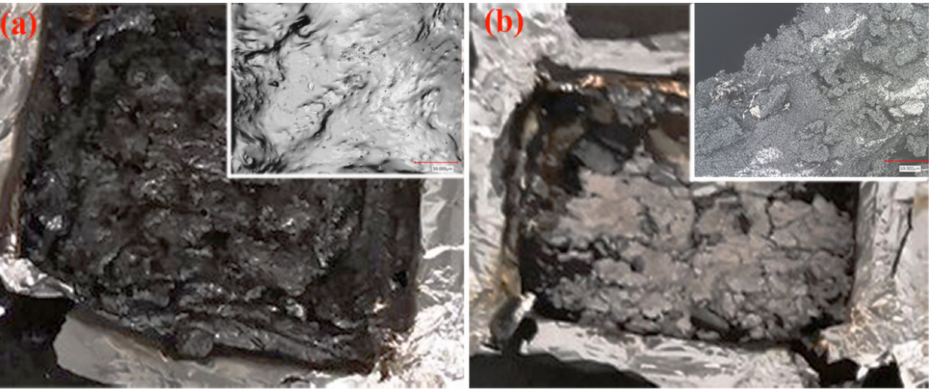
Figure 7. Digital photos and micro-morphology of char formation on the resulting composites, ( a ) multilayered wood flour/HDPE/PC composites, and ( b ) single-layer wood flour/HDPE composites.